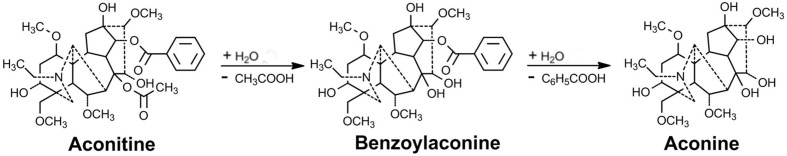
Illustration of the aconitine detoxification process by the two-step ester hydrolysis.